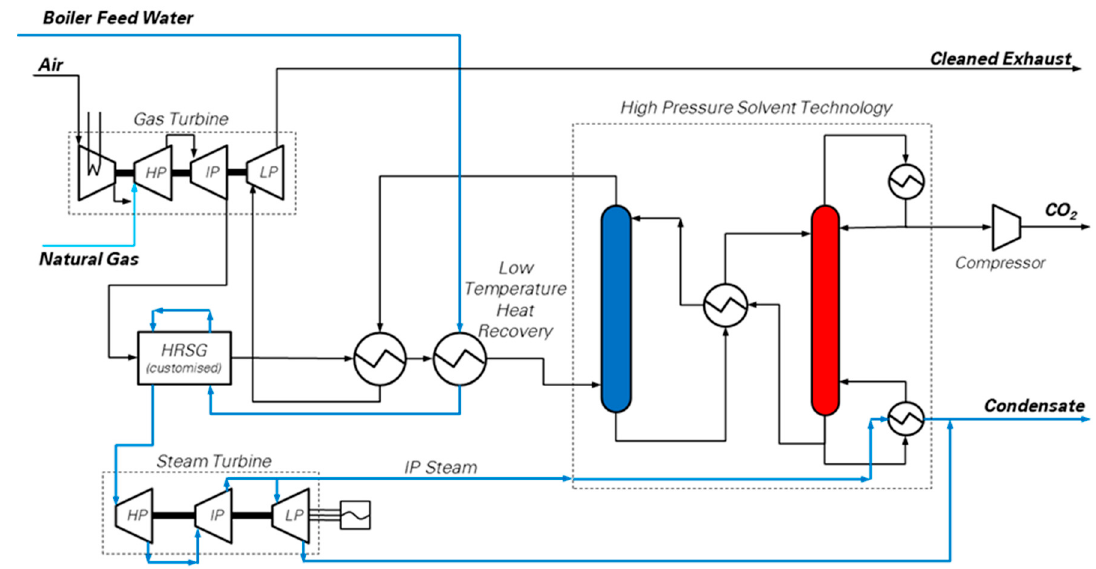
Figure 5. Simplified process flow diagram of the pressurized CO 2 solvent absorption integrated with multi-shaft gas turbine and Heat Recovery Steam Cycle (HRCS) [25]. The High Pressure Solvent Technology box is a simplified version of the CO 2 capture unit based on hot potassium carbonate (detailed scheme reported by Christensen et al. [11]), aiming at highlighting the main connections of the power plant with the absorber (process column in blue) and the regenerator (process column in red). (Picture reprinted with permission from Elsevier, Energy Procedia, Vol 114, Jonathan Forsyth,